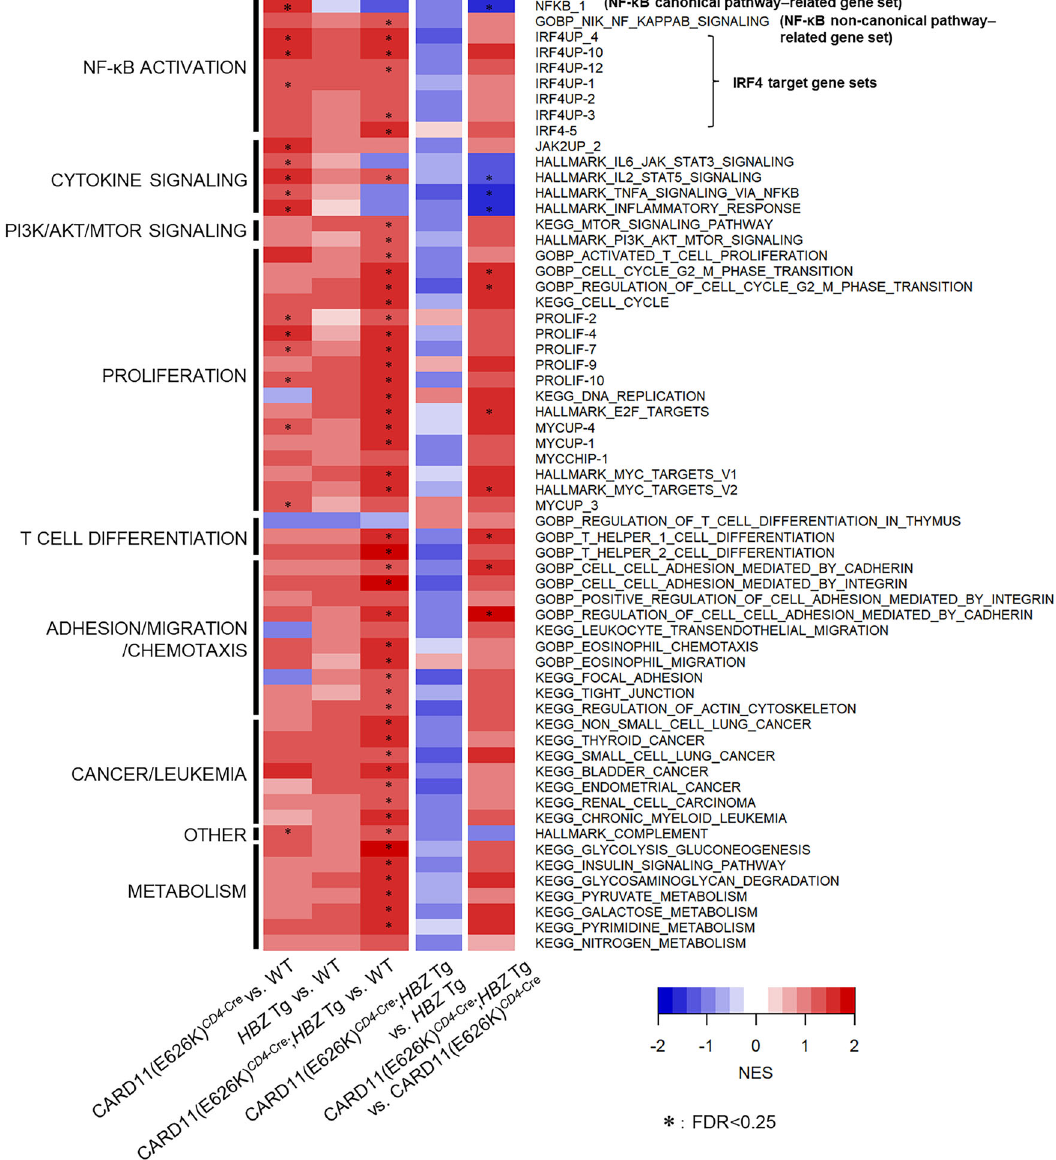
Fig. 7 Heatmap overview of gene sets showing signi fi cant enrichment by GSEA in one or more mutant Tem compared to WT Tem. Comparisons of results are shown in the following order: CARD11(E626K) CD4 -Cre vs. WT, HBZ Tg vs. WT, CARD11(E626K) CD4 -Cre ; HBZ Tg vs. WT, CARD11(E626K) CD4 -Cre ; HBZ Tg vs. HBZ Tg, and CARD11(E626K) CD4 -Cre ; HBZ Tg vs. CARD11(E626K) CD4 -Cre